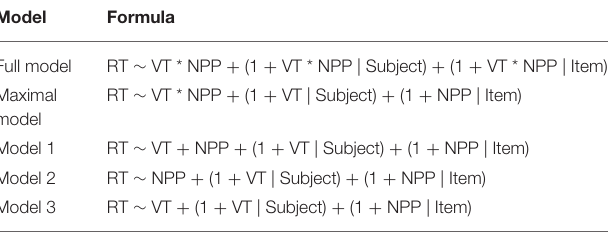
FIGURE 2 | Relation between reading time (at NP + 1) and NP predictability by verb type. The x-axis shows NP predictability, and the y-axis shows reading times (in milliseconds). The red squares represent reading times of NP + 1 for each item in the aspectual verb condition; the black dots represent reading times of NP + 1 in the non-preferred verb condition; and the blue triangles represent the reading times of NP + 1 in the preferred verb condition. The three lines on this scatter plot indicate linear regression lines for the three verb types, the red line for the aspectual verb condition, the black line for the non-preferred verb condition, and the blue line for the preferred verb